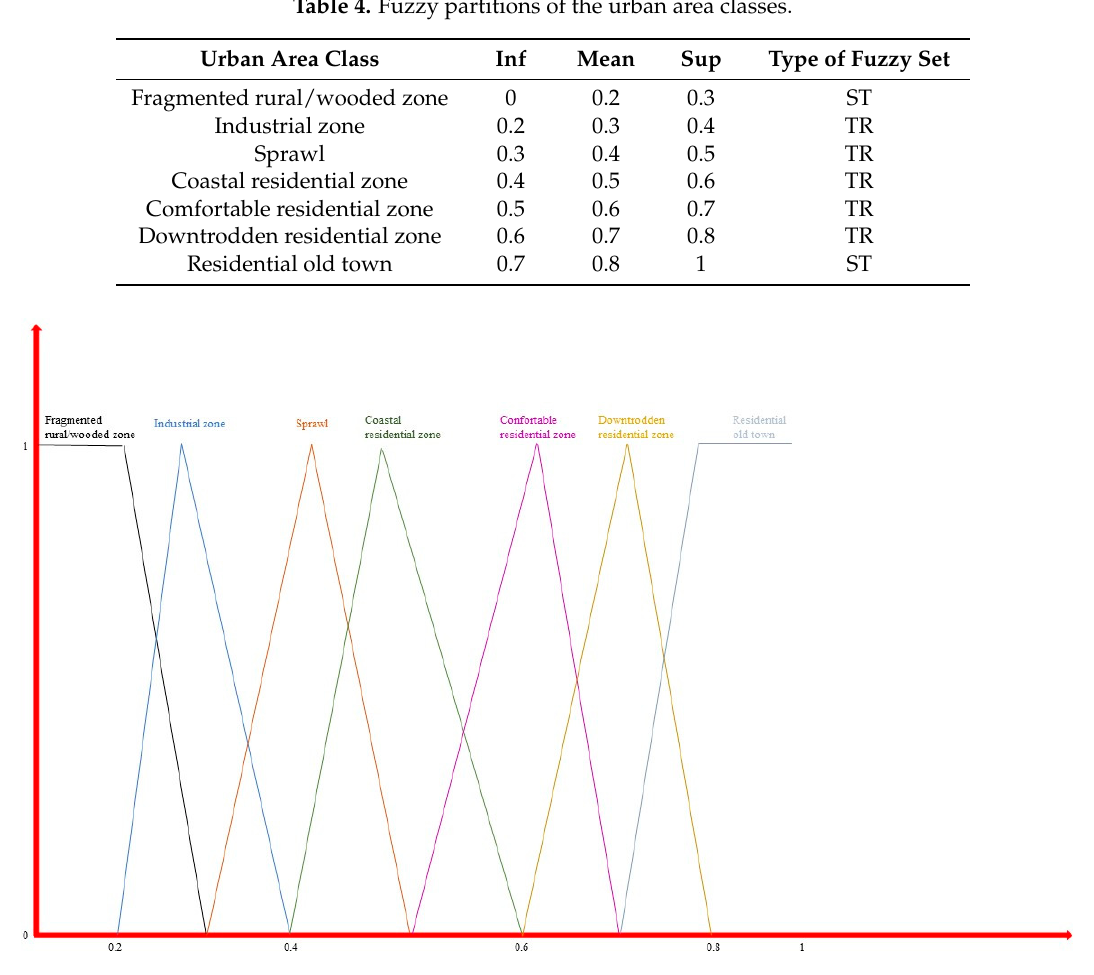
Table 4. Fuzzy partitions of the urban area classes.